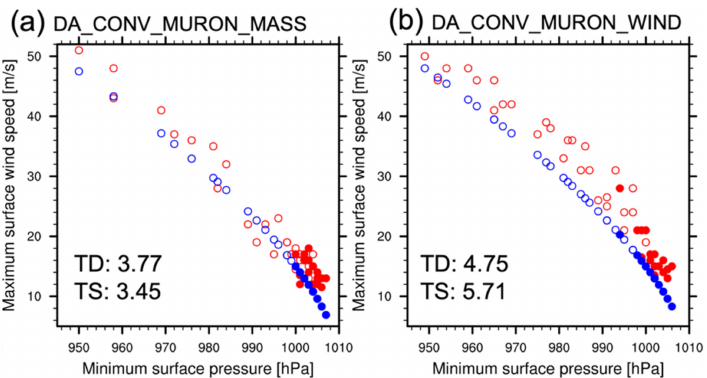
Figure 13. Scatter plots between MSLP and maximum 10-m wind speed for ( a ) the DA_CONV_MURON_MASS and ( b ) DA_CONV_MURON_WIND experiments. The red circles denote the relationship between MSLP and maximum 10-m wind speed (VMAX) from the analysis and 6-h, 12-h, 18-h, and 24-h forecasts from all DA cycles. The blue circles denote the relationship between the MSLP and minimum 10-m wind speed ( VMAX AH ) derived from the pressure–wind relationship of Atkinson and Holliday (1977). The filled circles represent the wind and SLP from the TD stage, and the open circles represent the wind and SLP from the TS stage. The number denotes RMS difference between the VMAX of the DA experiments and the corresponding VMAX AH averaged over the TD stage cycles (TD) and the TS stage cycles